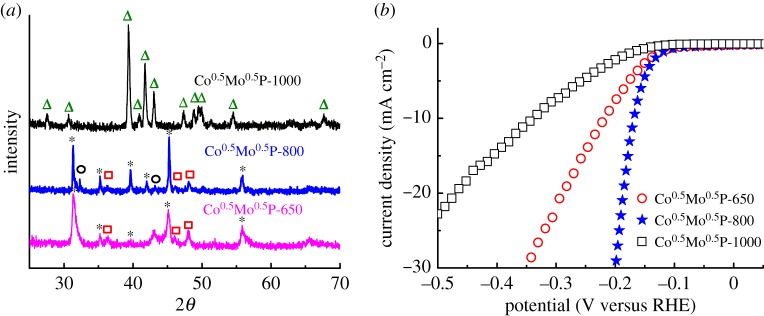
(a) X-ray diffraction patterns and (b) HER polarization curves of the Co0.5Mo0.5P samples annealed at 650°C, 800°C and 1000°C. The assignments of the diffraction peaks are included: black hollow circle, hexagonal MoP; red hollow square, orthorhombic CoP; black asterisk, hexagonal CoMoP2; green hollow triangle, orthorhombic CoMoP. The HER polarization curves were collected in hydrogen-purged 0.1 M HClO4 solution.